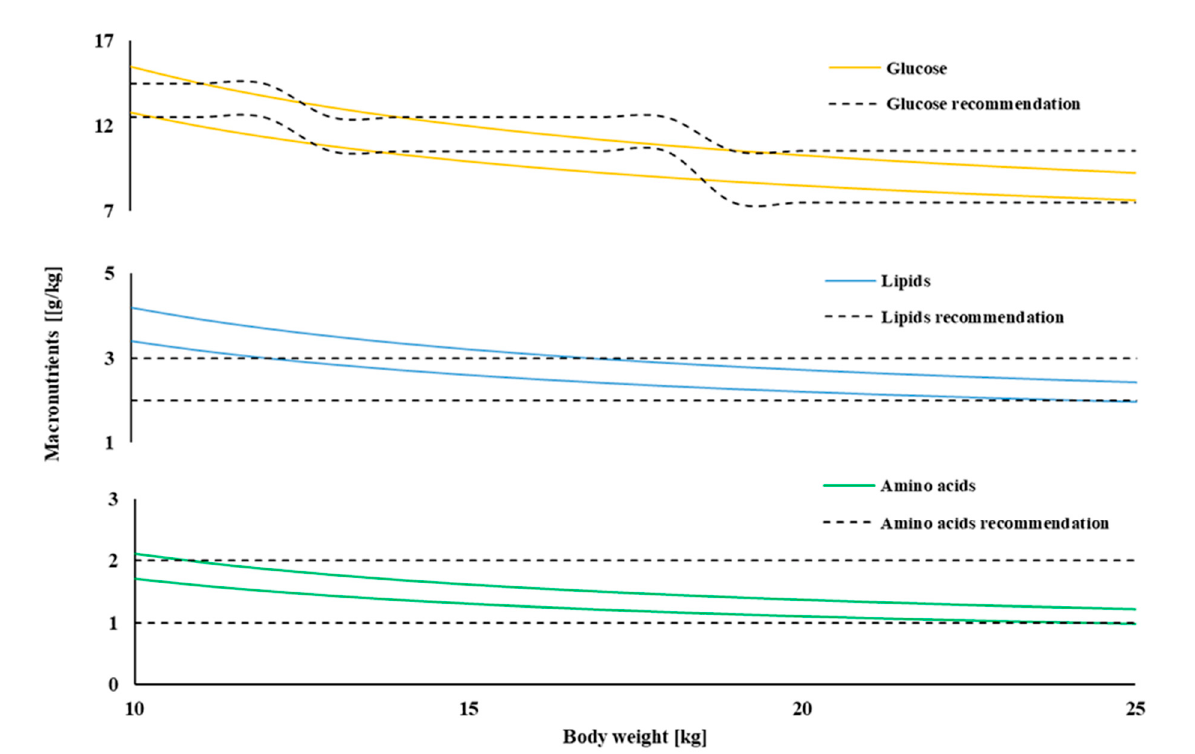
Figure 1. The macronutrients doses ranges in the function of patients’ bodyweight in relation to ESPEN/ESPGHAN recommendation. Table 1. The concentration range of ingredients of PN admixtures.